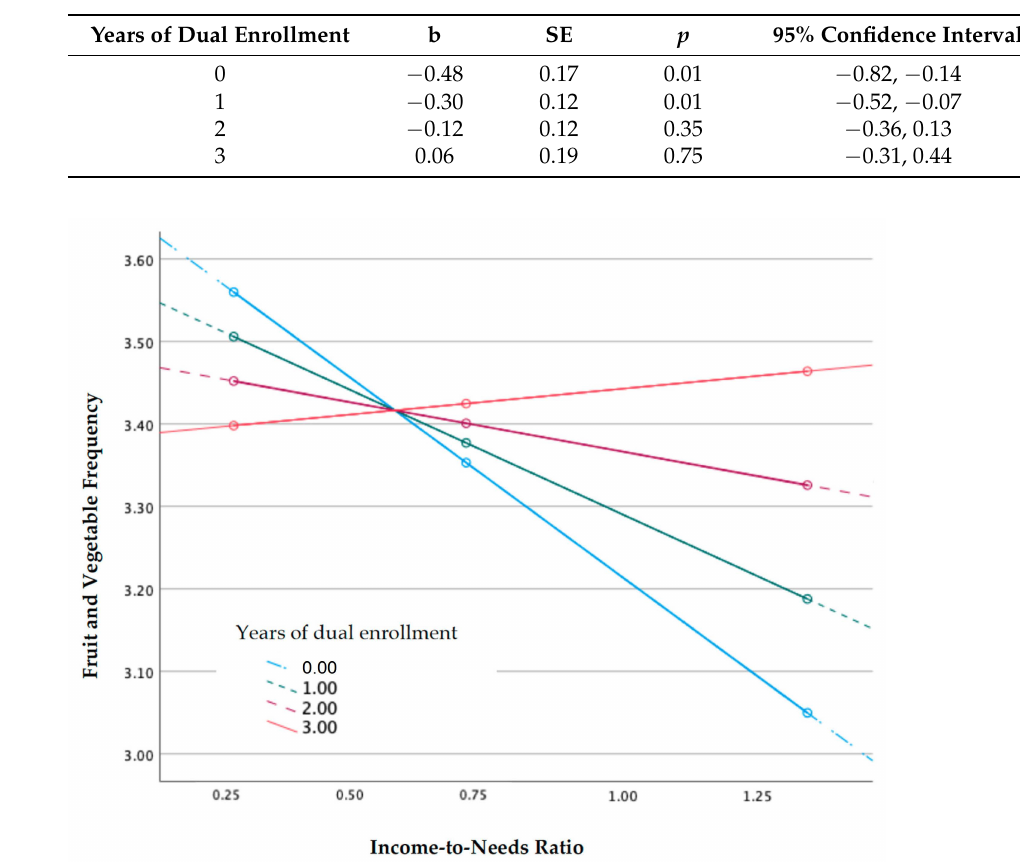
Table 5. Moderated Effects of Income-to-needs ratio on change in FV Consumption Frequency across years of accumulated dual WIC and SNAP enrollment.